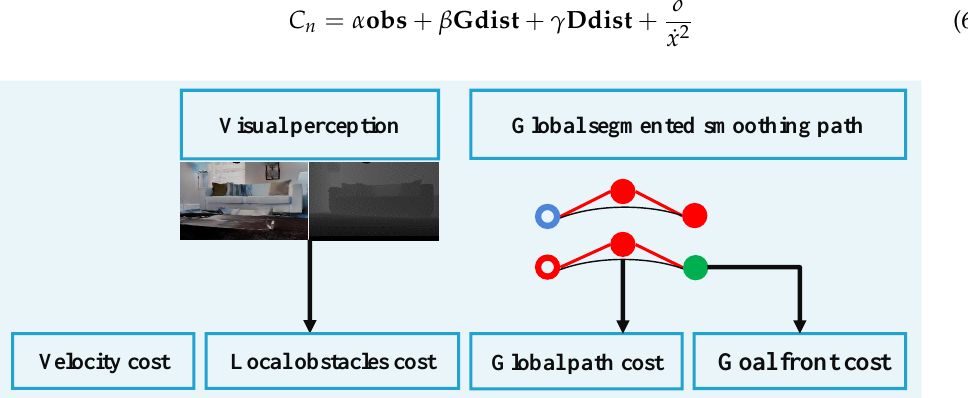
Figure 14. The block diagram outlines the specific modules in the proposed multi-constrained local path planning